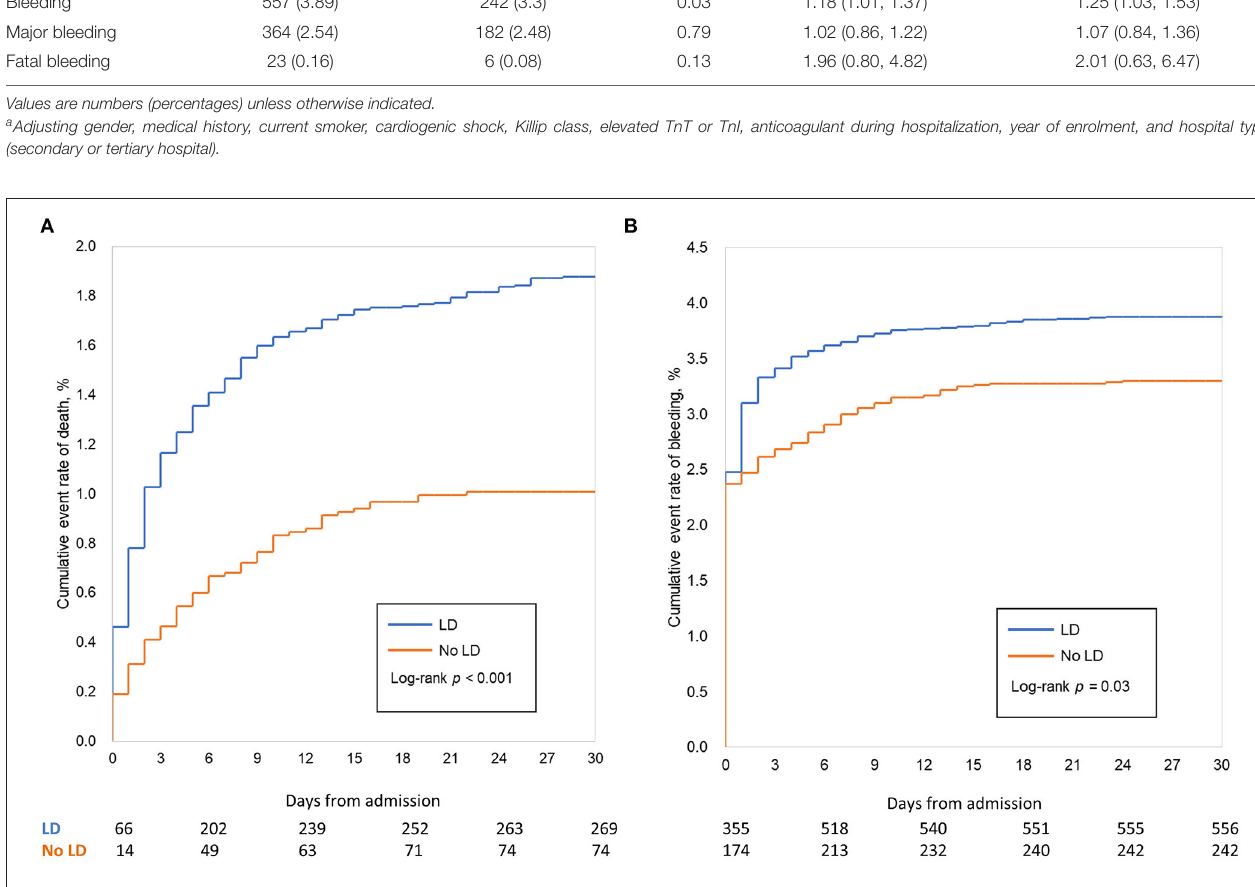
FIGURE 2 | In-hospital clinical outcomes (unadjusted analysis). Cumulative Kaplan–Meier curve estimates of effectiveness outcomes during the 15-day in-hospital period in the whole study population: mortality (A) , major bleeding (B) . In-hospital mortality was significantly lower in patients treated without dual loading dose of antiplatelet therapy (No LD) compared with those who were. The overall incidence of in-hospital bleeding after percutaneous coronary intervention (PCI) was 3.69%; after adjustment for patient characters and hospital effects (Cox model), LD was associated to higher rate of